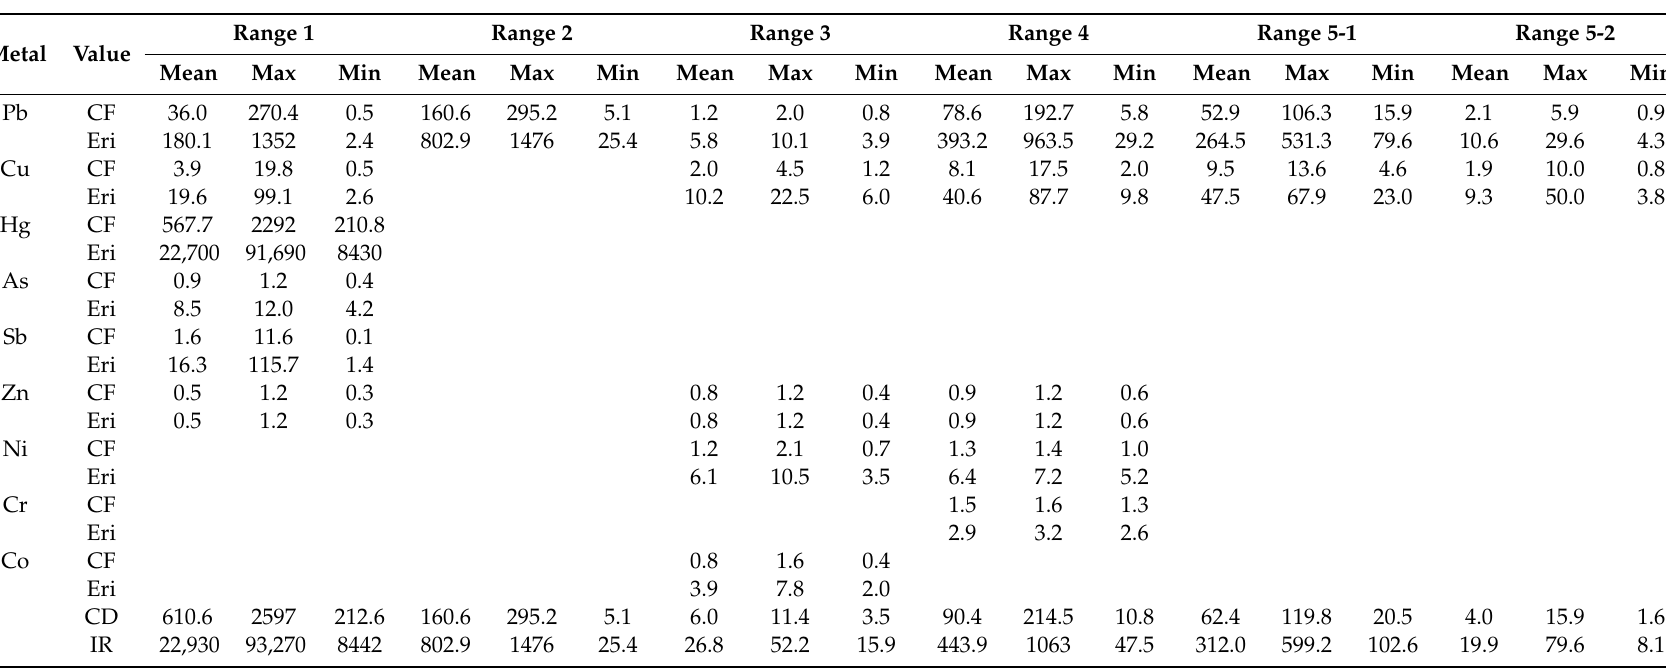
Table 2. Contamination factor (CF), contamination degree (CD), ecological risk factor (Eri), and potential ecological risk index (RI) of heavy metals in the shooting ranges. Metal